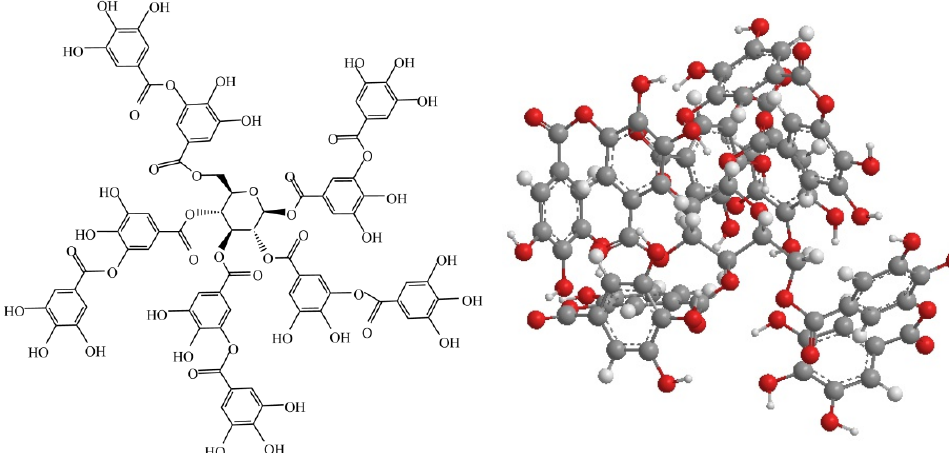
Figure 1. Chemical molecular structure diagram of tannins.